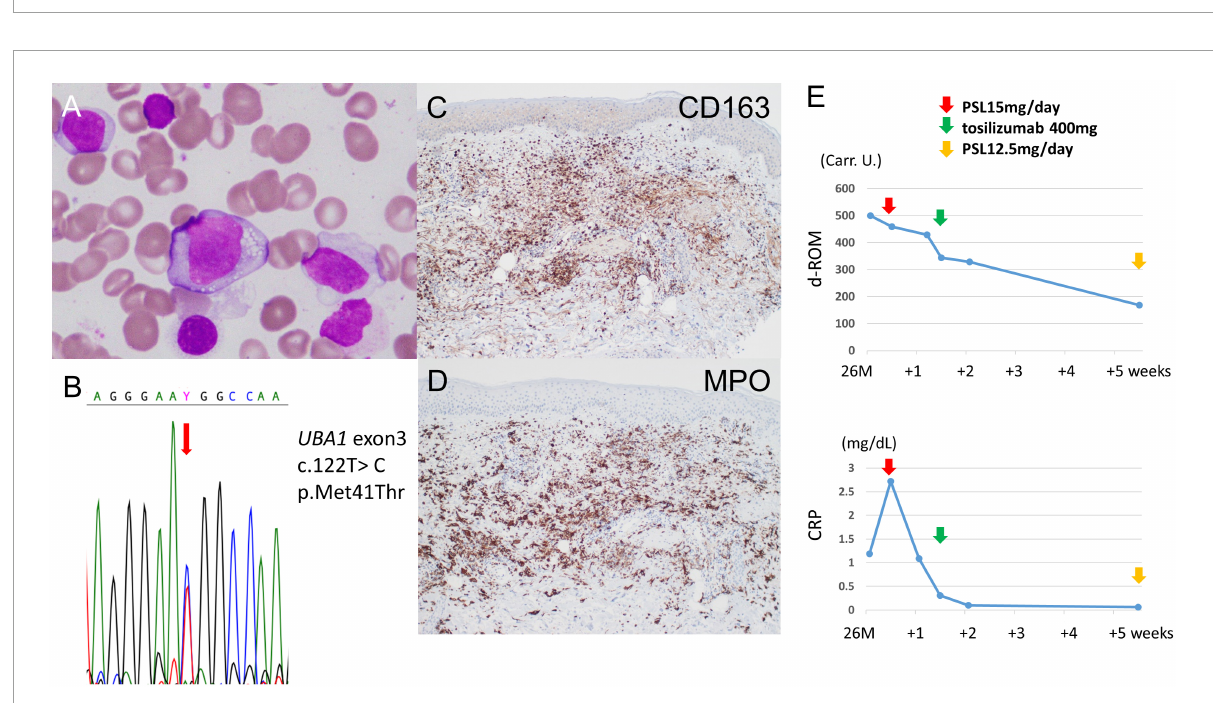
FIGURE3 Additional tests for diagnosis and treatment. (A) Bone marrow aspirate smears show cytoplasmic vacuolization in myeloblasts ( × 40 magnification). (B) Sanger sequencing of genomic DNA derived from whole peripheral blood. The c.122T > C mutation is detected at position p.Met41 of the UBA1 gene. (C) There are many CD163-positive cells, suggesting macrophages and histiocytes in the dermis (CD163 immunostaining, original magnification × 100). (D) The majority of infiltrates are MPO-positive (MPO immunostaining, original magnification × 100). (E) Serum d-ROM level before and after treatment. The d-ROM levels are expressed in Carratelli units (Carr. U.). The d-ROM levels decreased significantly after treatment with oral prednisone (15 mg/d) and the first intravenous injections of tocilizumab (400